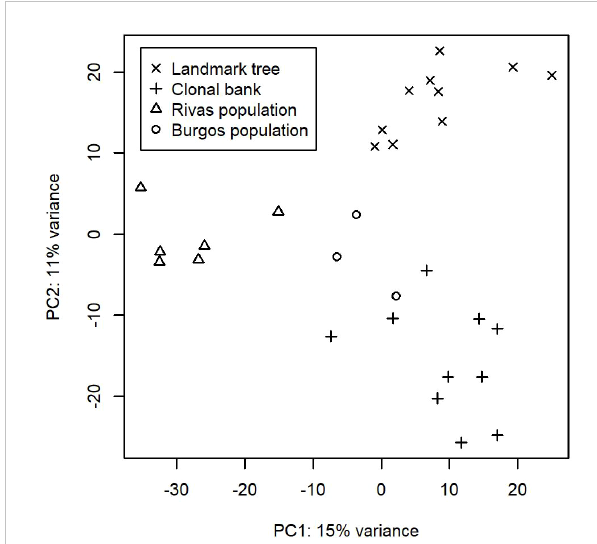
FIGURE 2 First two axes from the Principal Component Analyses performed on the OTU counts after variance stabilizing